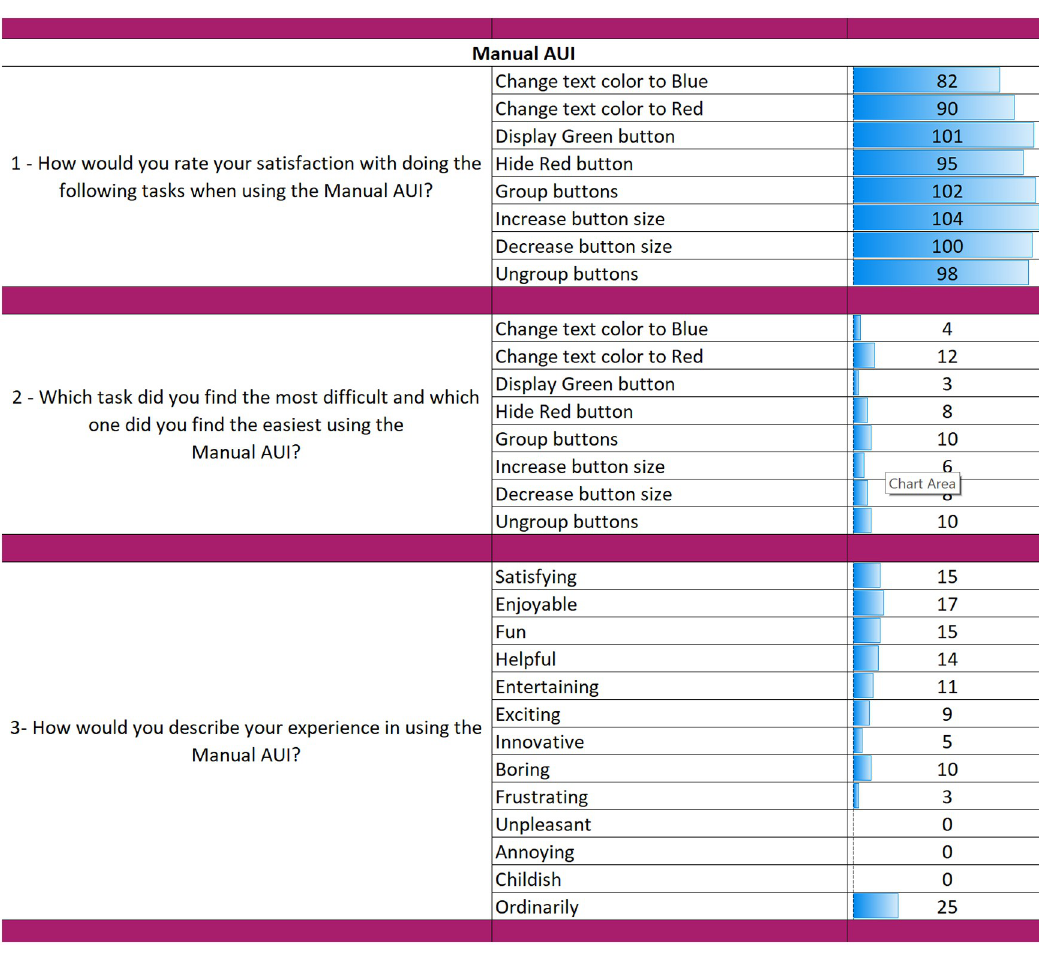
Fig 18. Questionnaire results for the Manual